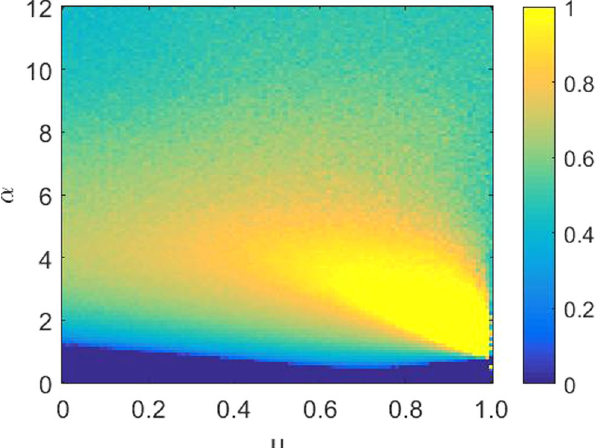
Figure 5. The color-coded (see bar on the right) fraction of cooperation ρ c on the α - u parameter plane. When α = 0 and u = 0, it will turn to the traditional game, where cooperators go extinct soon. However, when the heterogrneity preference is considered, the fraction of cooperation can be promoted obviously with the increase of parameter α and u . In particular, for each fixed u value, the optimal α value for promoting cooperation lies between 2.0 and 6.0. All the results are obtained for b = 1.05, L × L = 10 4 nodes, k = 4 and K =